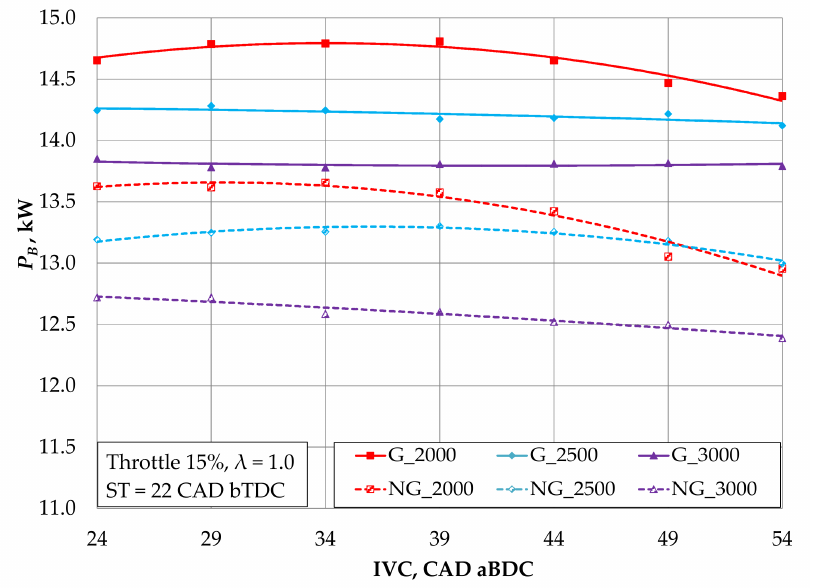
Figure 6. Engine power with gasoline and natural gas and intake valve close